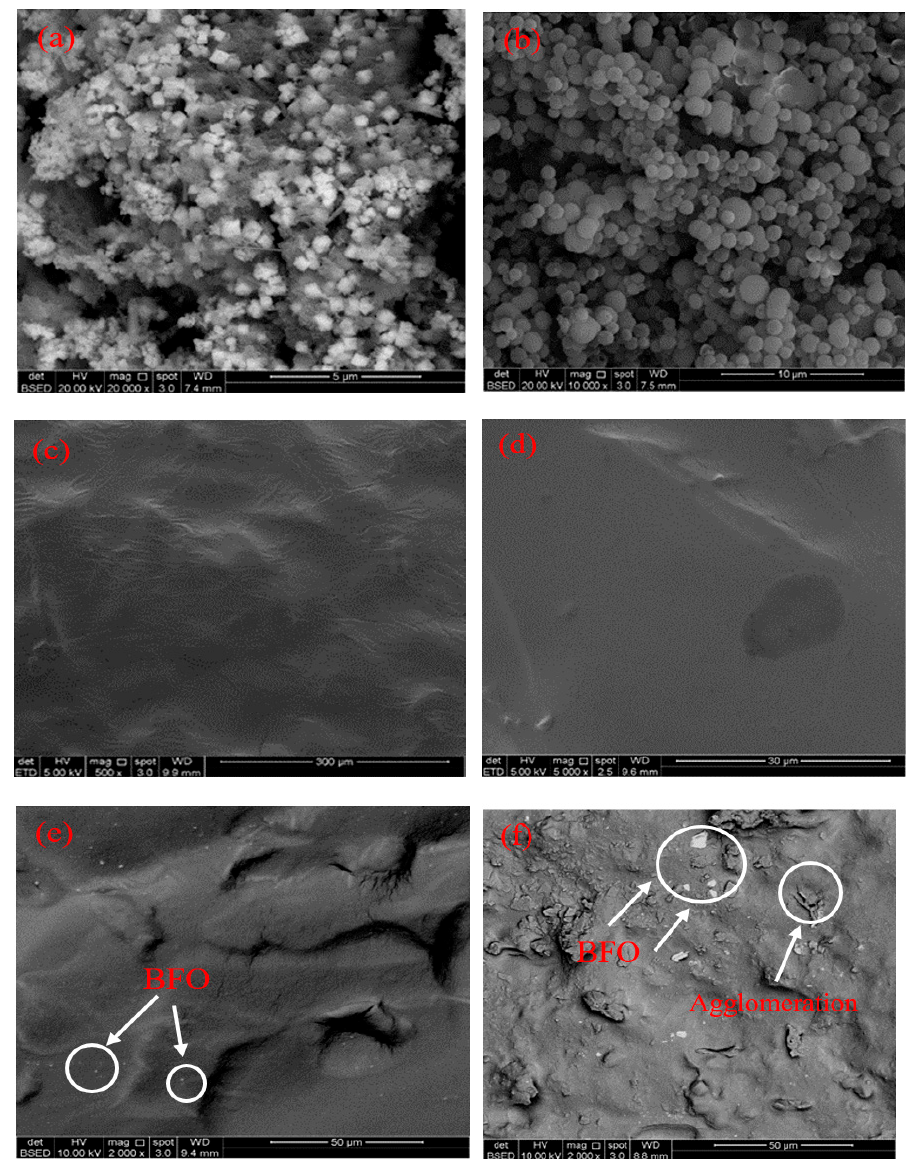
Figure 3. SEM images for ( a ) BFO powder, ( b ) PoPD powder, ( c ) CMC, ( d ) CMC/CNC MCC , ( e ) CMC/BFO/PoPD, and ( f ) CMC/CNC MCC /BFO/PoPD composite film.